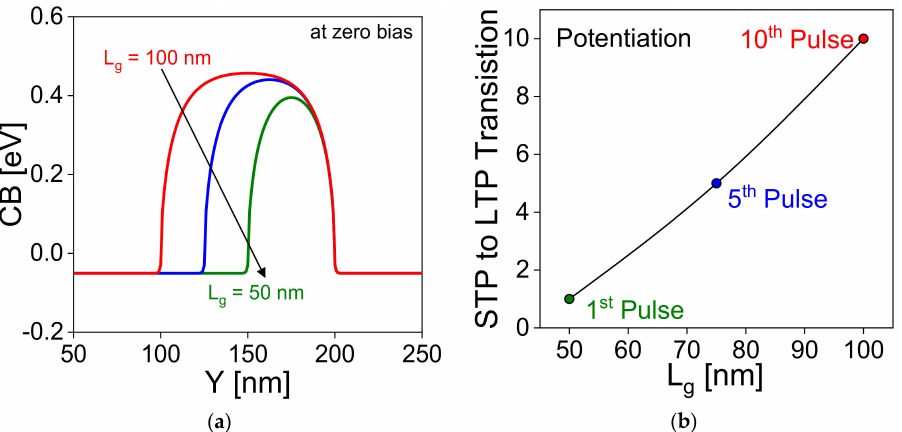
Figure 9. Downscaling of gate length. ( a ) Variation of CB energy. ( b ) number of pulses required for the transformation from STP to LTP. CB and VB indicate conduction and valence band, respectively.